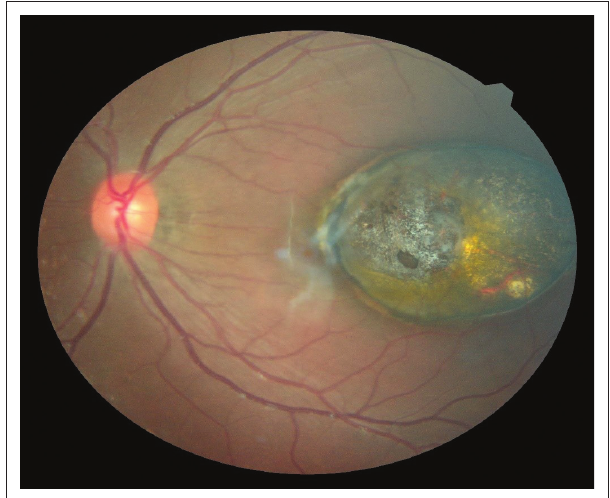
FIGURE 2: Colour fundus photograph of the left eye showing the chorioretinal geographical map scar of old toxoplasmosis. This photo shows a fundamental defect to the choroid with the sparing of the macula, especially the fovea centralis.